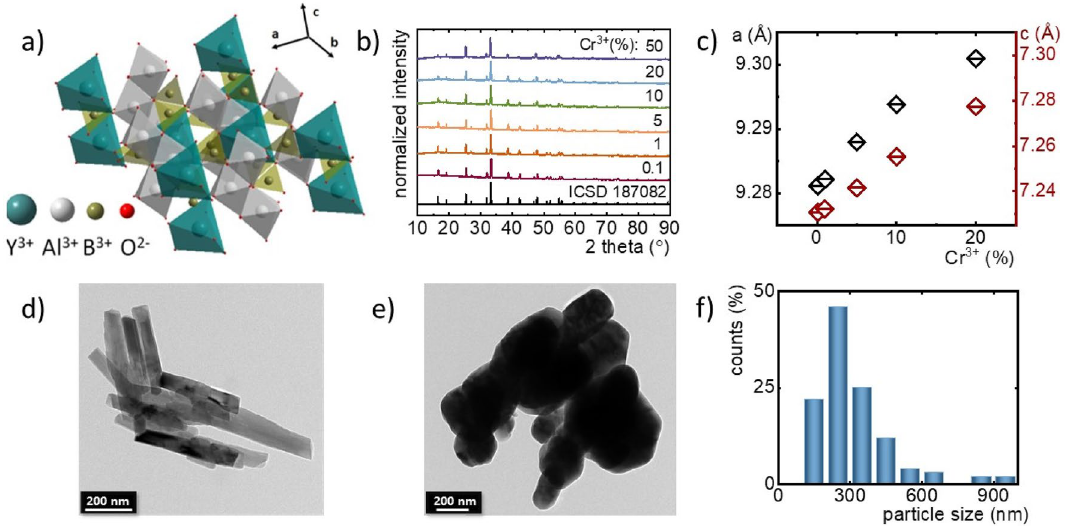
Figure 1. Structural and morphological characterization of the synthesized materials: the simple visualization of polyhedral structure of YAl 3 (BO 3 ) 4 borate—( a ); XRD patterns for YAl 3 (BO 3 ) 4 : (0.1; 1; 5; 10; 20; 50)% Cr 3+ — ( b ); dependence of unit cell parameters a and c on Cr 3+ concentration—( c ); representative TEM images of YAl 3 (BO 3 ) 4 : 0.1% Cr 3+ —( d ) and YAl 3 (BO 3 ) 4 : 20% Cr 3+ —( e ), histogram of the nanoparticle size distribution calculated based on TEM images of YAl 3 (BO 3 ) 4 : 20% Cr 3+ —( f